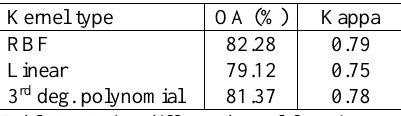
Table 1. Using different kernel functions